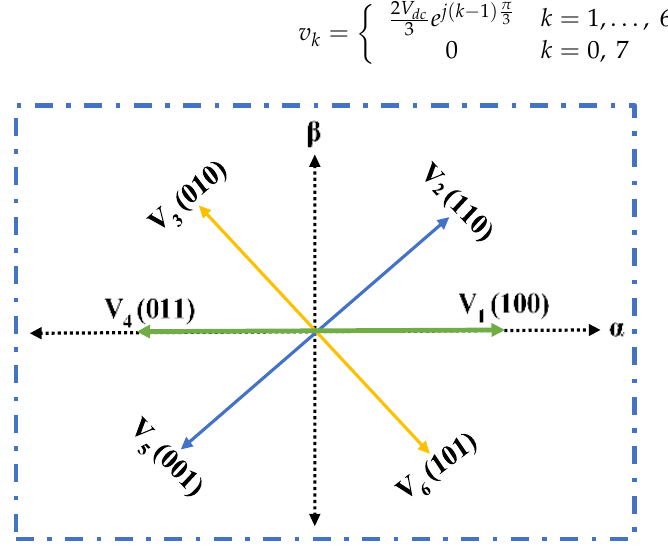
Figure 1. Parallel decentralized MGs.